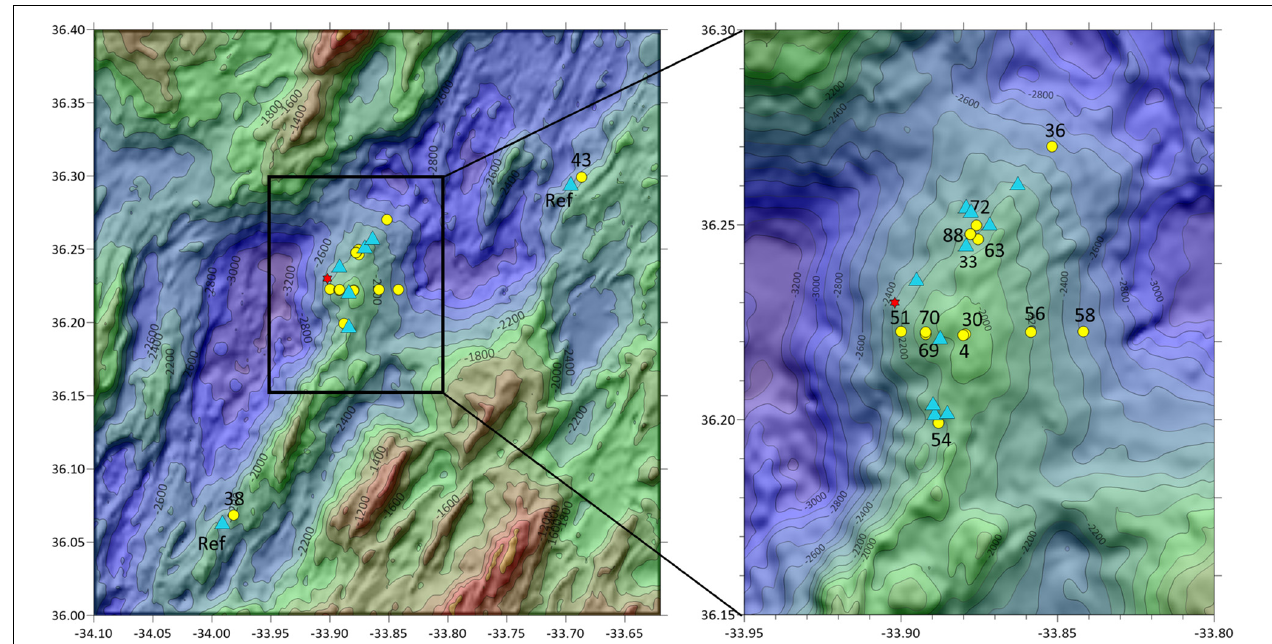
FIGURE 1 | Sampling map. Sampling stations of box core (yellow circle) and water/larvae (blue triangle) samples around the Rainbow hydrothermal vent (red star). Stations numbers depict the box core sample stations. The analysis of the water samples was clustered per area: NE and SE of the vent site and